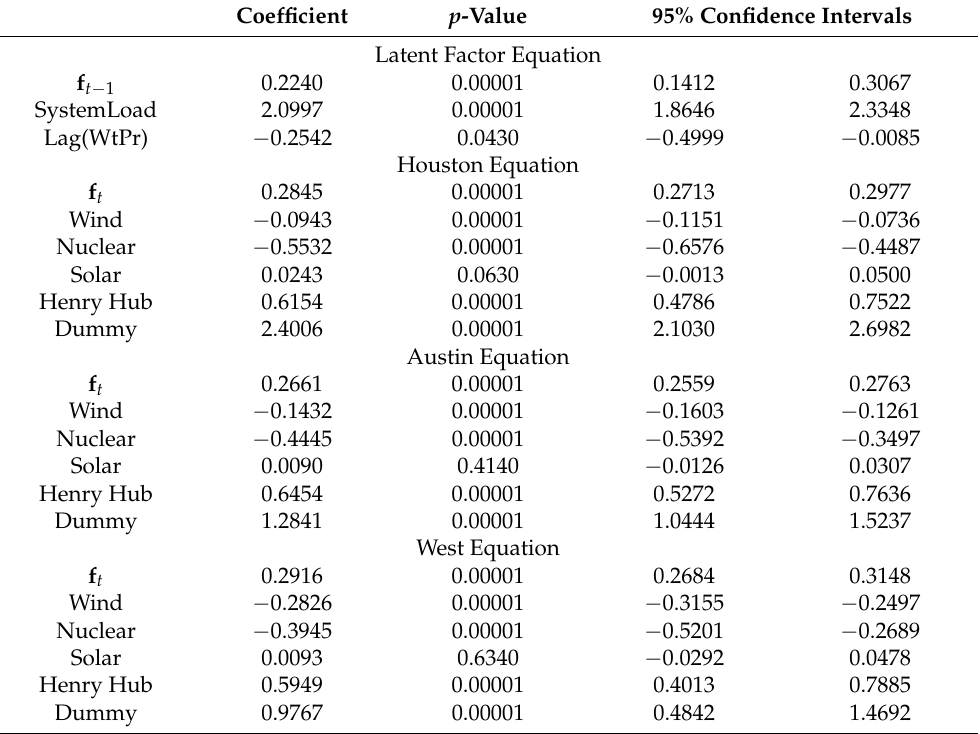
Table 5. ML coefficients for the 12:00 p.m.